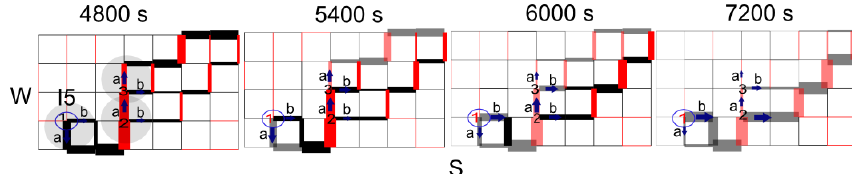
Figure 13. Evolution of SW edge of the network in from Fig. 11 before and after transition to free-surface flow.